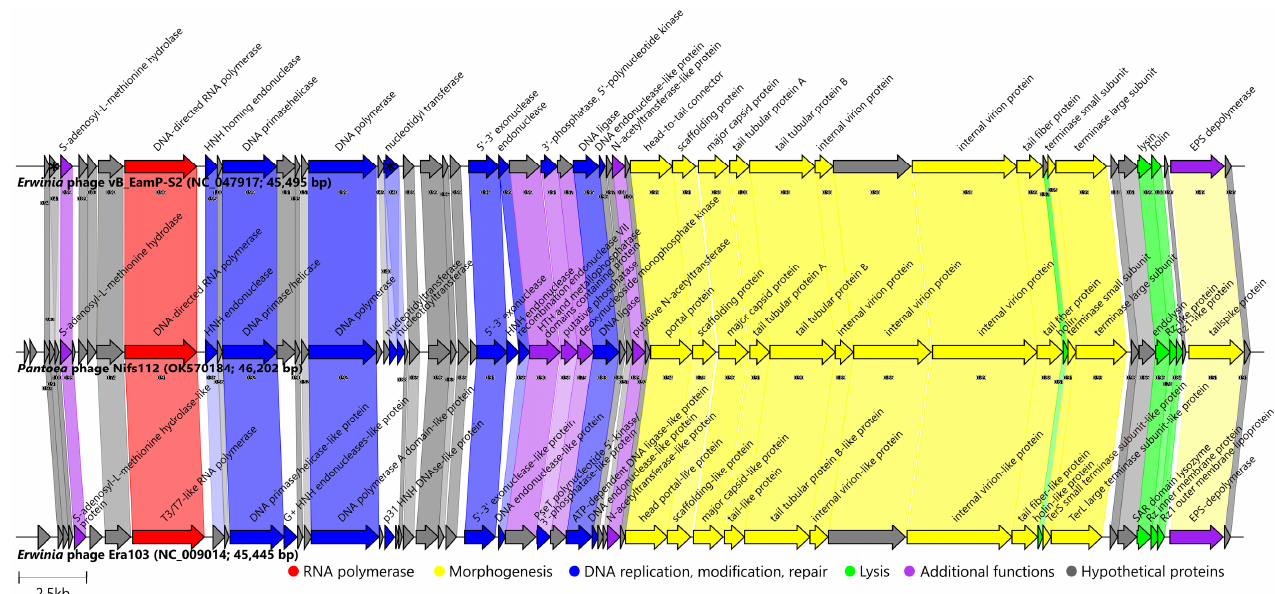
Figure 6. Genome organization and proteome content comparison of Pantoea phage Nifs112 to its closest relatives. Genomes are drawn to scale; the scale bar indicates 2500 base pairs. Arrows representing open reading frames point in the direction of the transcription and are color-coded based on the function of their putative product according to the legend. Slanted labels above the arrows indicate the predicted function for the given ORF putative product in the case where it had a function assigned (original annotations from downloaded GenBank files were retained). Ribbons connect phage proteins sharing >30% amino acid sequence similarity and are colored in lighter shades according to the predicted functional group of the respective Pantoea phage Nifs112 ORF product. Ribbon labels indicate the similarity between the connected ORF products and ribbons have their fill color opacity set to the percentage similarity between the respective proteins. Asterisks within two of the arrows representing vB_EamP-S2 ORFs indicate that their homologs in Nifs112 were encoded by two distinct ORFs in each